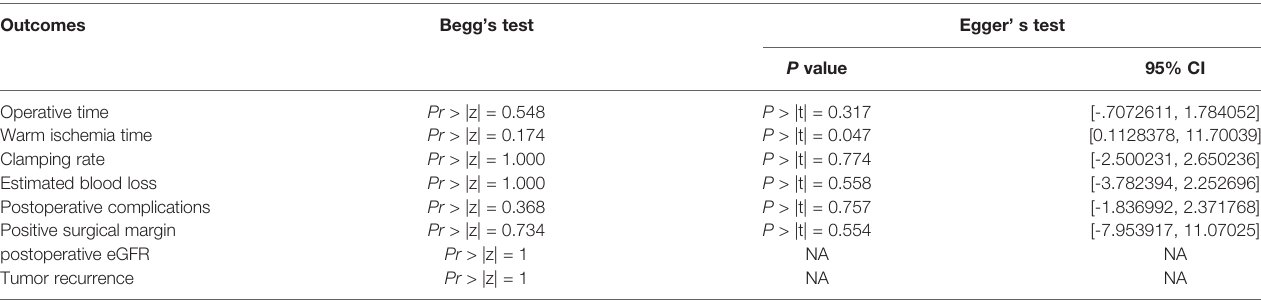
TABLE 3 | Publication